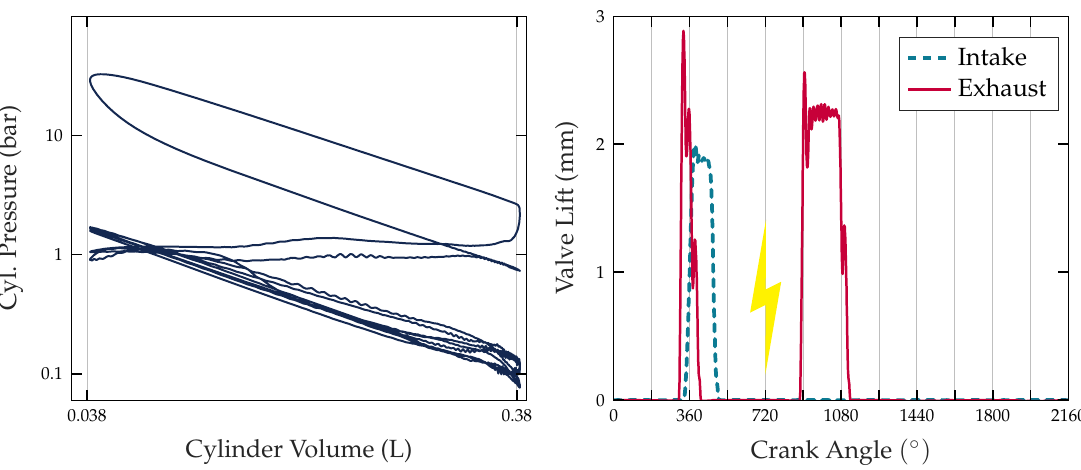
Figure 6. Measured pV diagram and corresponding valve timings of the 12-stroke operation point with EVC 1 = 390 ◦ CAaITDC and an indicated efficiency of 34.3% at 5Nm of indicated torque per cylinder. The lightning bolt indicates ITDC.